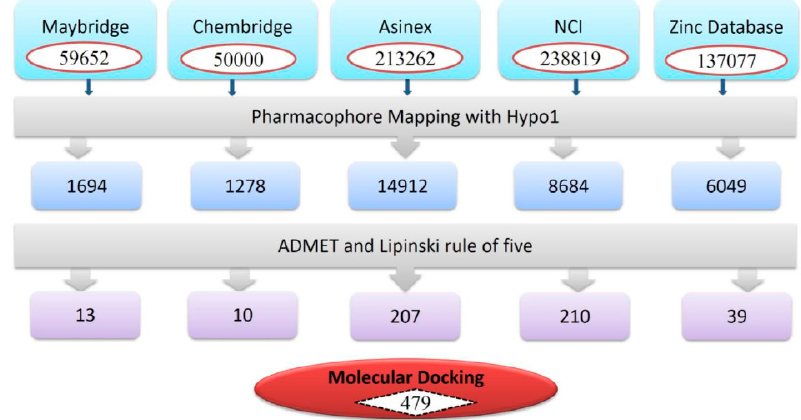
Figure 5. Schematic flow of the virtual screening. Hypo1 was employed as 3D query for virtual screening. ADMET assessment test and Lipiniski’s rule of five were used as filtration systems to identify drug-like compounds.